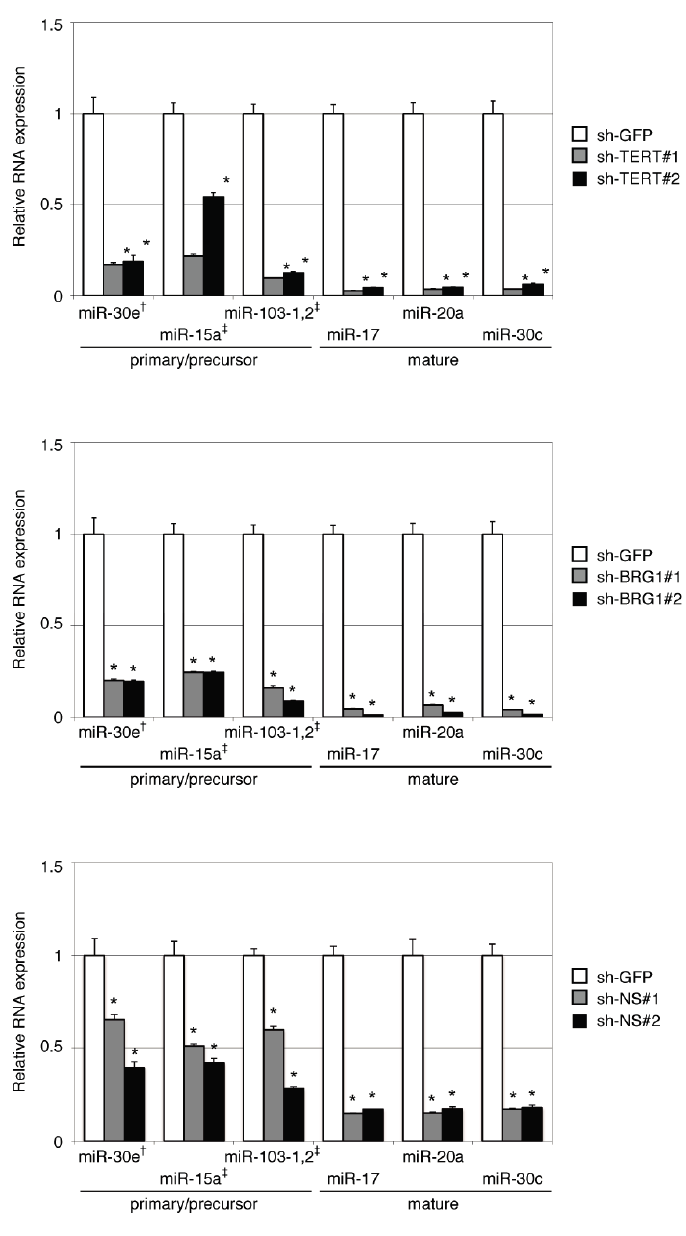
Figure 3. Comparable effects of TERT, BRG1 and NS in miRNA expression. The expression levels of mature miRNAs and miRNA precursors were examined with RT-qPCR upon suppression of TERT ( top ), BRG1 ( middle ) or NS ( bottom ) by gene-specific shRNAs. For miRNA precursors, there are the primers amplified primary form ( † ) or both primary and precursor forms ( ‡ ). The relative amount of the individual miRNAs was normalized to U6 , and the mean expression levels in sh-GFP refer to one. Values represent the means ± SD for three independent experiments. Asterisks represent p < 0.05 compared with